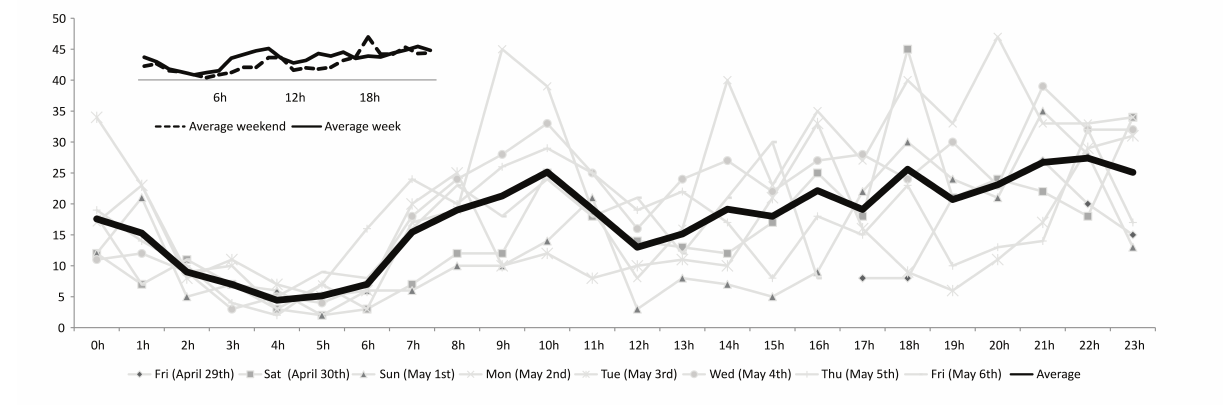
Figure 6. Temporal patterns of migraine headache tweets in the United States. Tweets were converted to local times and corrected for daylight savings time. The averaged flow of migraine tweets accumulated at 10h, persisted and gradually peaked later at night (22h). During Saturday and Sunday (dashed line in the top-left graph), the highest peak occurred at